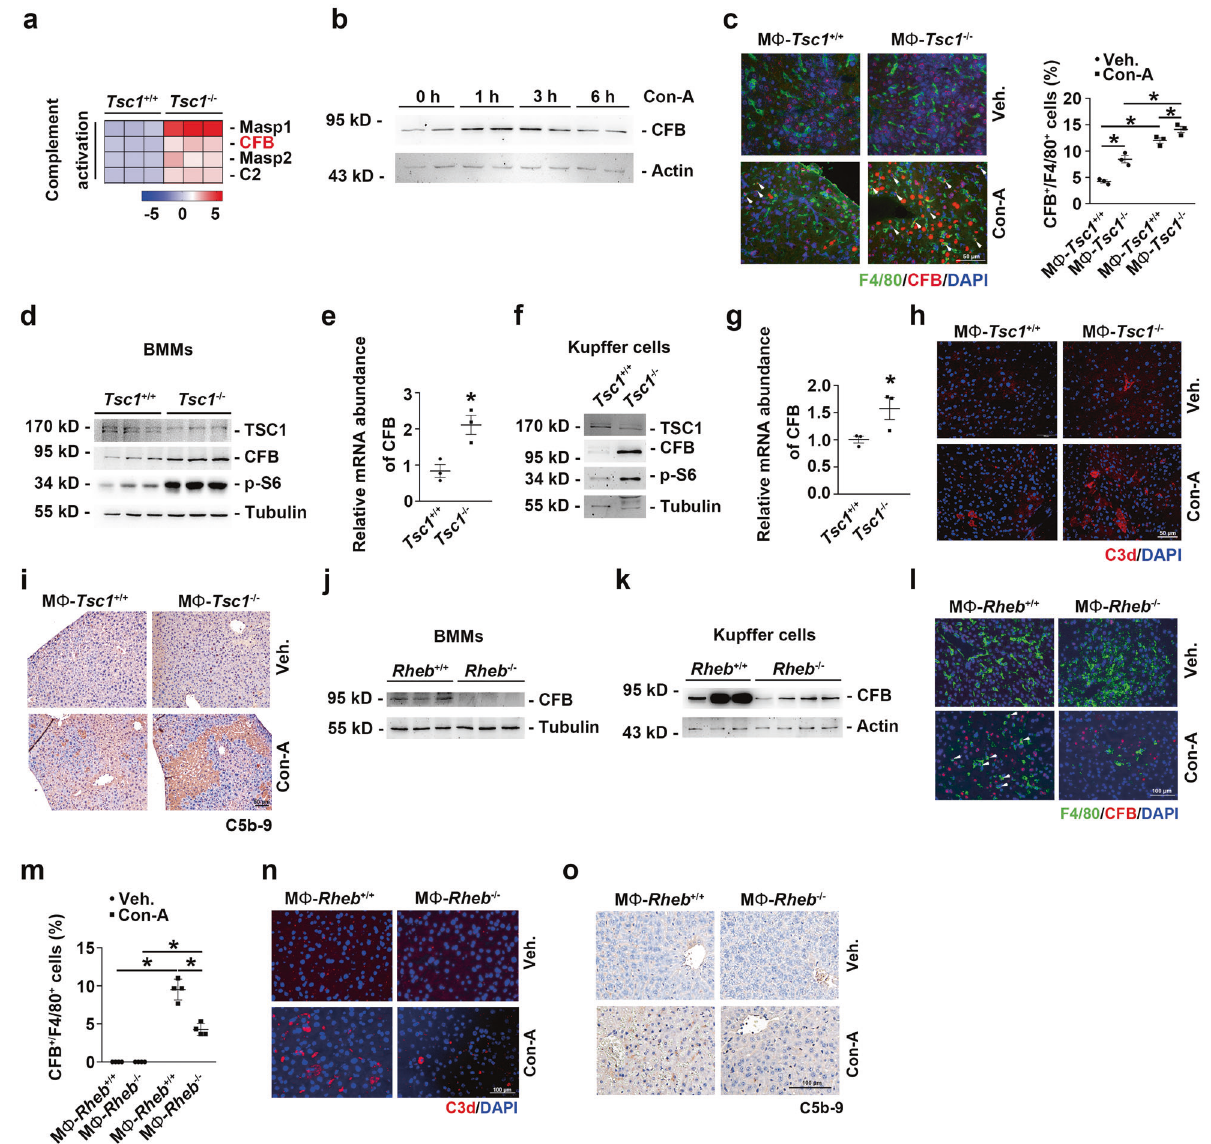
Fig. 5 The activation of mTORC1 in KCs enhances complement alternative system. a Expression heatmap of genes of neutrophils chemotaxis or complement activation analyzed by RNA-seq from Tsc1 + / + and Tsc1 -/- BMMs ( n = 3 each). b Western blotting result was shown the expression of CFB protein in hepatic tissues from mice. c Left, representative co-immuno fl uorescent staining images for F4/80 with CFB. Scale bar = 50 μ m. Right, quantitative determination of F4/80 + and CFB + cells among groups as indicated, n = 3. d Western blotting assay showing the abundance for TSC1, CFB, and p-S6 in BMMs. e qRT-PCR analysis showing the CFB mRNA abundance in BMMs, n = 3. f Western blotting assay showing the abundance for TSC1, CFB, and p-S6 in KCs. g qRT-PCR analysis showing the CFB mRNA abundance in KCs, n = 3. h